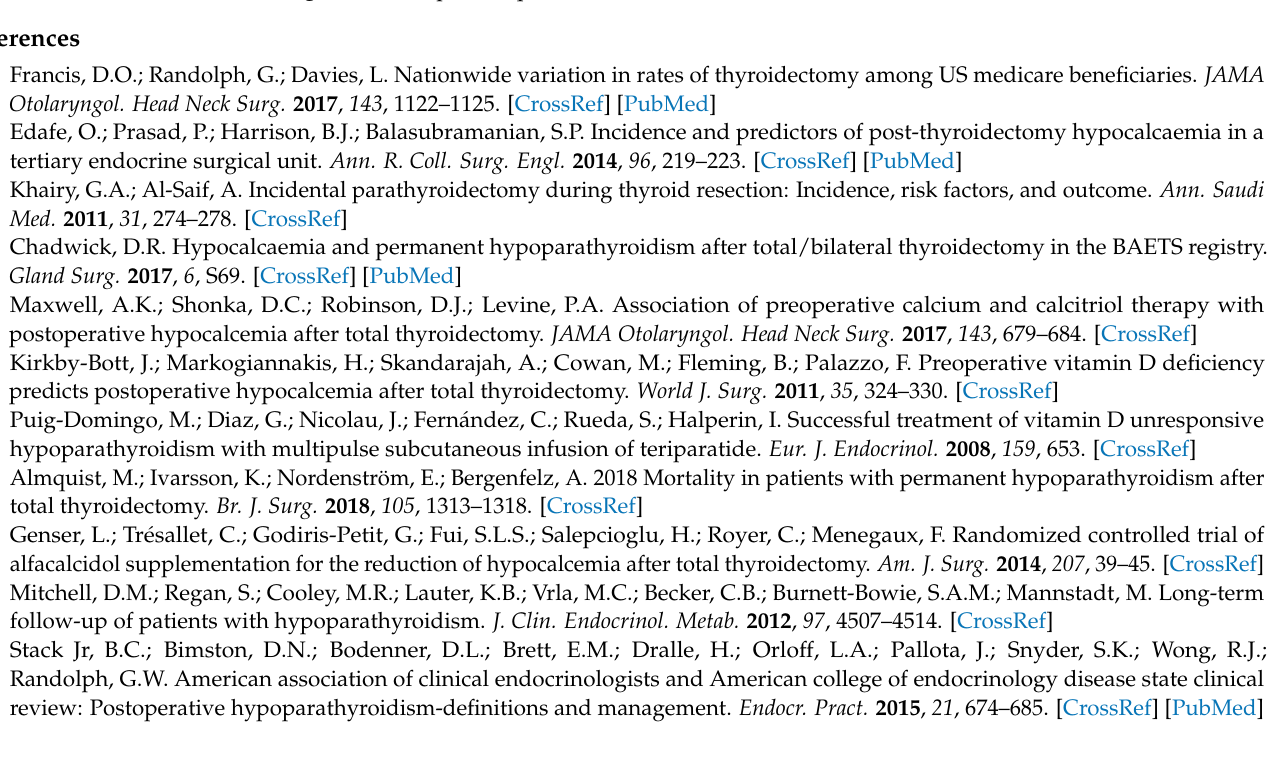
Figure A1. Telephonic questionnaire.